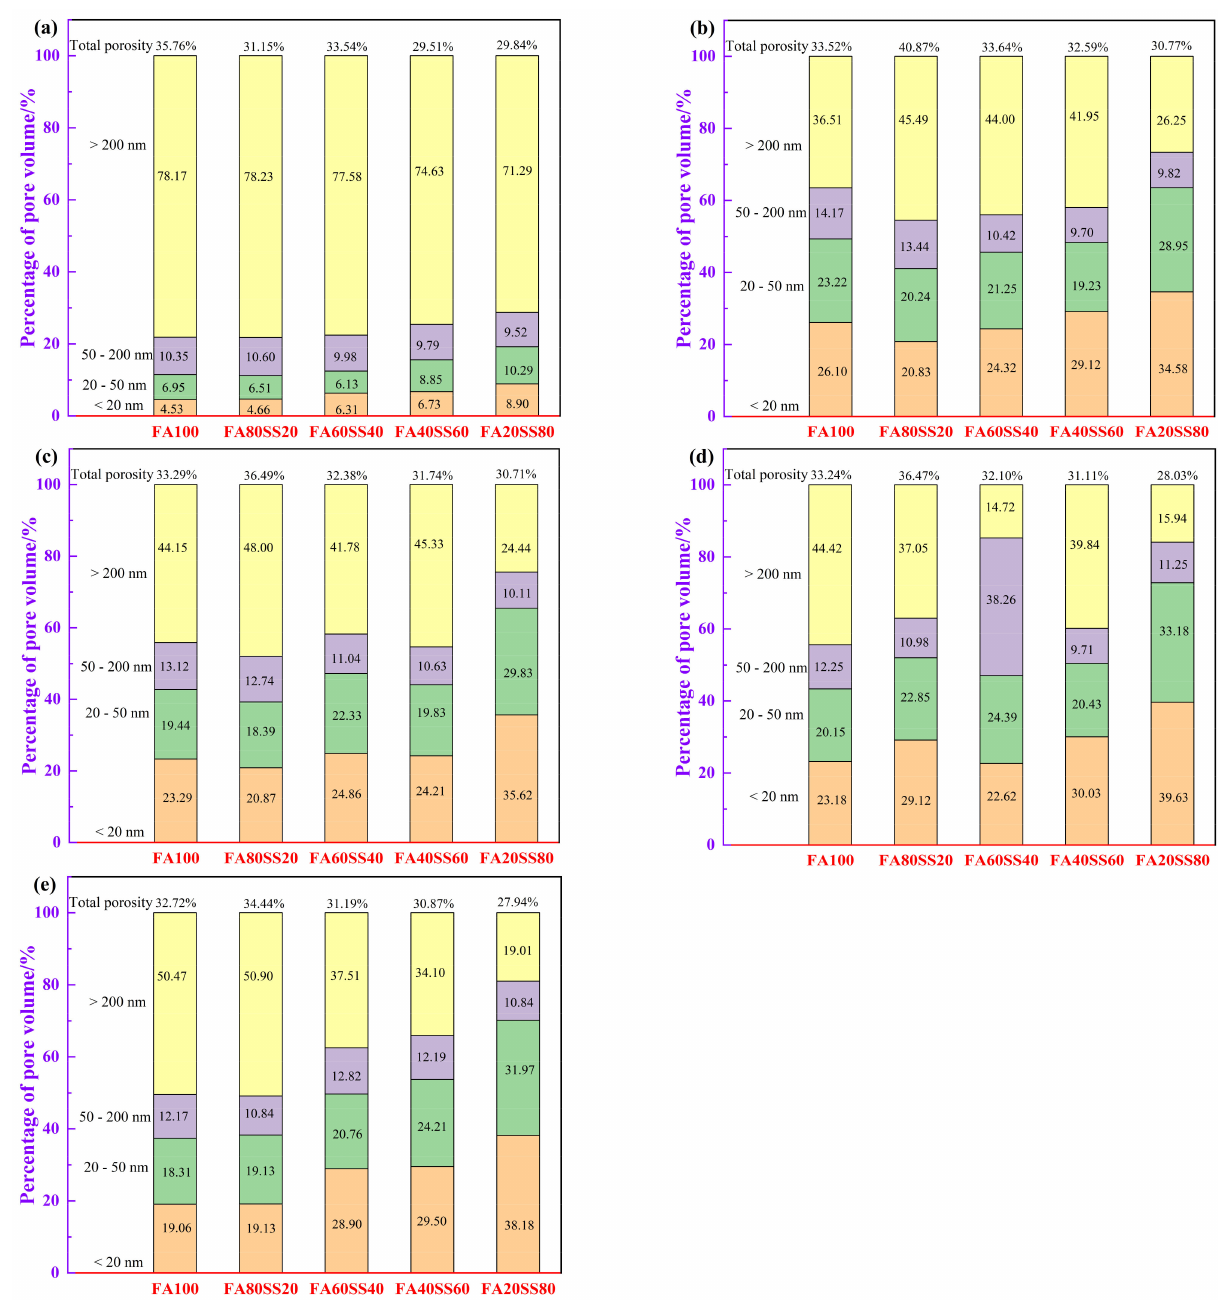
Figure 5. Total porosity and pore size percentage of precast geopolymers ( a ) at the age of 3 days and at different periods of water immersion: ( b ) 3 days, ( c ) 7 days, ( d ) 14 days and ( e ) 28